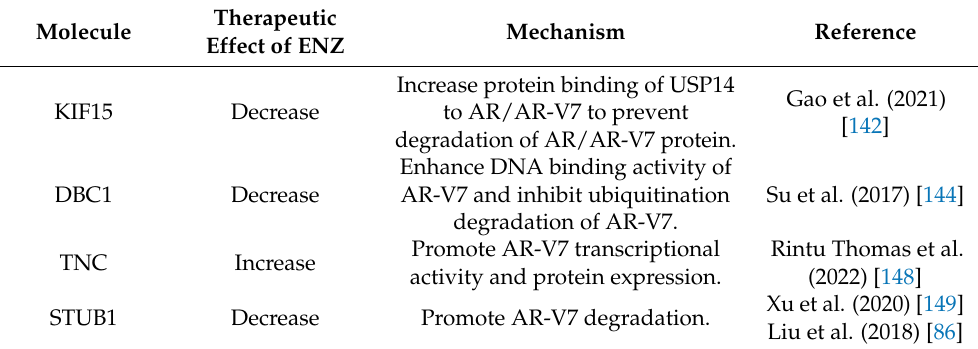
Table 3. Some molecules in patients with CRPC affect the therapeutic effect of ENZ.